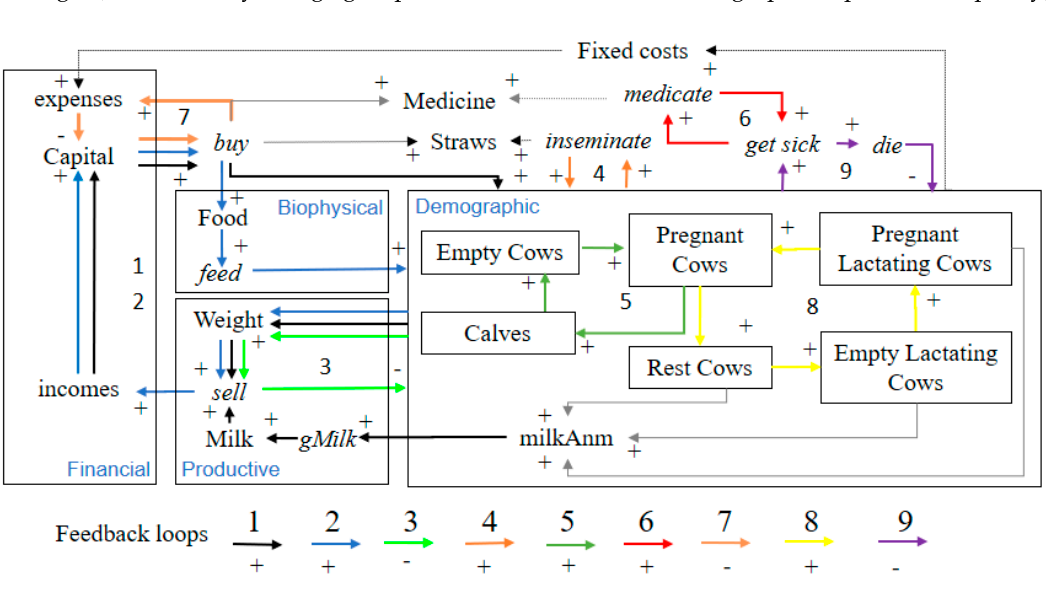
Figure 1. The first version of the simplified causal loop diagram.